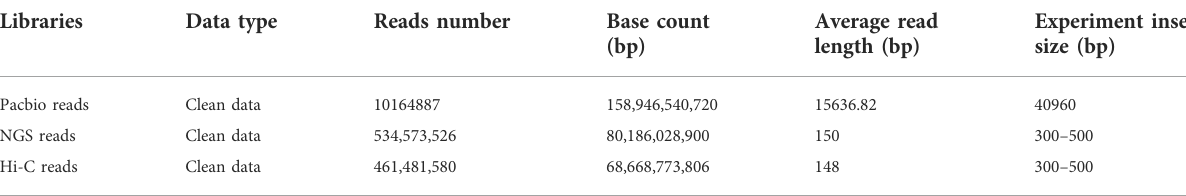
TABLE 1 Statistics of the genome sequencing data.